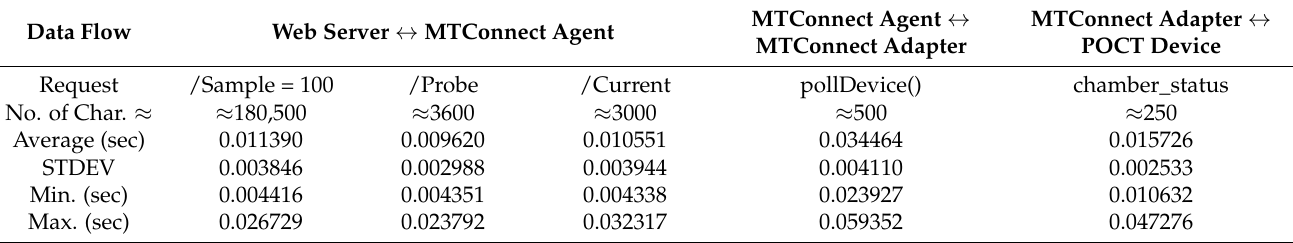
Table 1. Average response time of the implemented